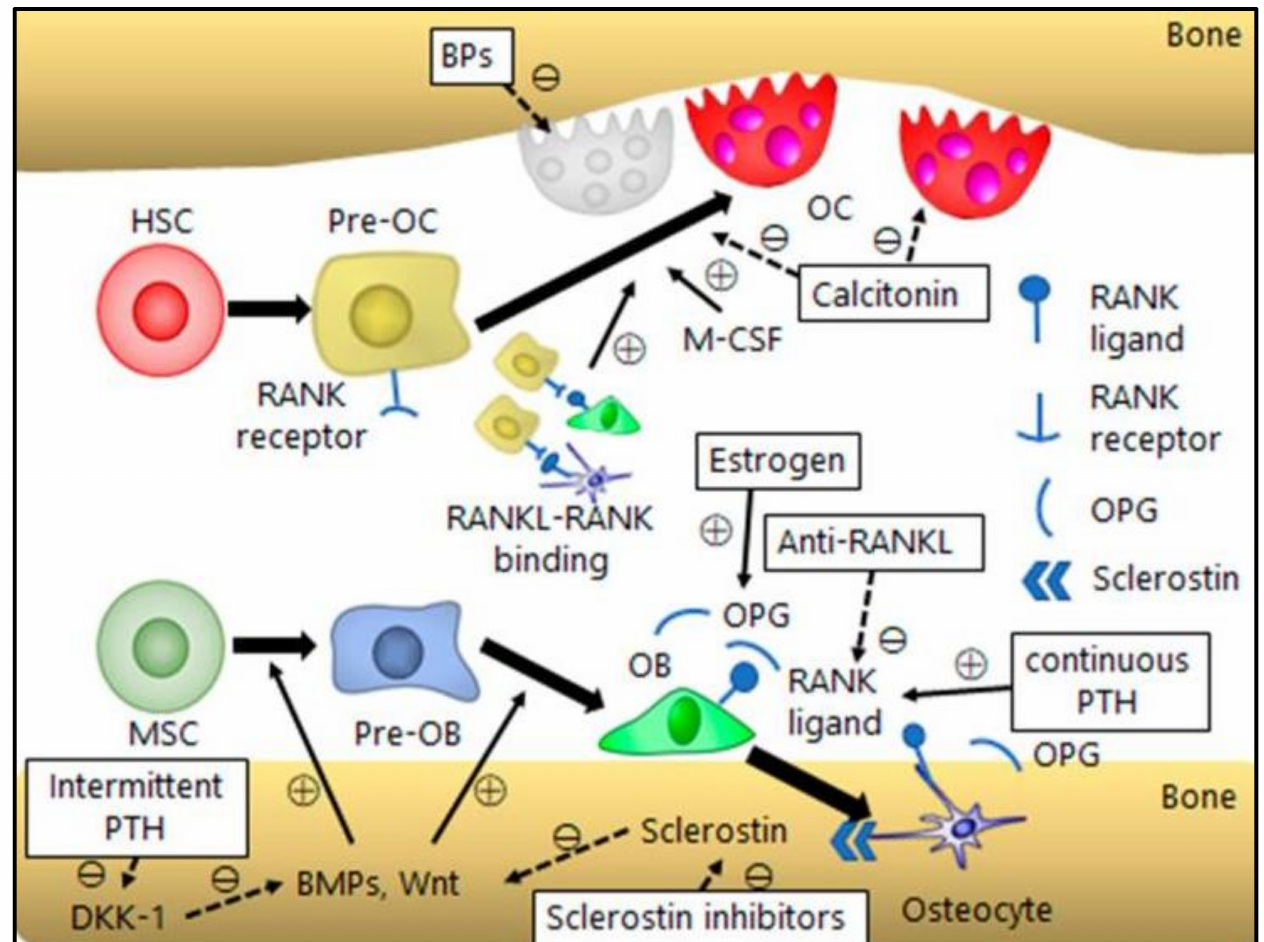
Figure 4. The mechanism of action of osteoporosis therapeutics. The antiresorptive drugs such as bisphosphonate (BP), estrogen, anti-RANKLs (denosumab) and calcitonin; anabolic drugs such as PTH and anti-sclerostins (romosozumab) affecting different bone cells. + mean positive effect; − mean negative effect